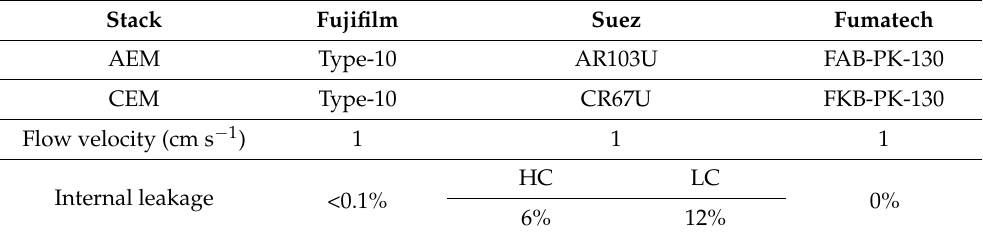
Table 3. Leakage test results using deionized water in all